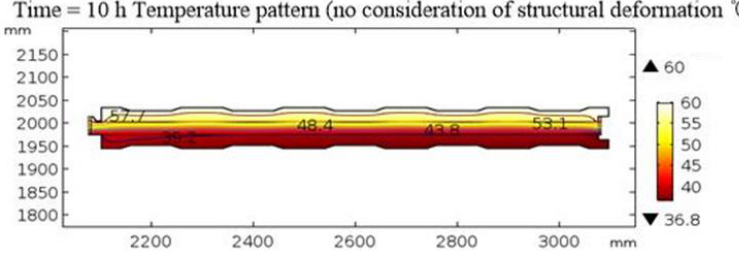
Figure 12. Effect of structural deformation on heat transfer.